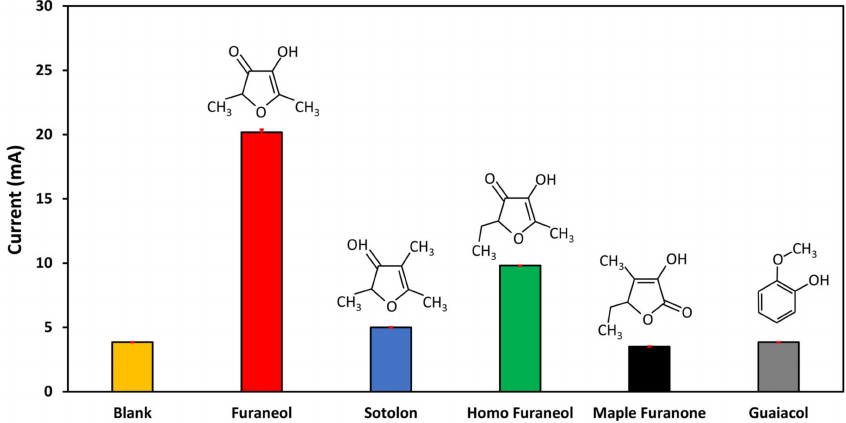
Figure 6. Test of the aptasensor for the detection of furaneol. The non-target analytes selected are sotolon, homo furaneol, maple furanone, and guaiacol. The concentrations of furaneol and non-target chemicals were 1 µ